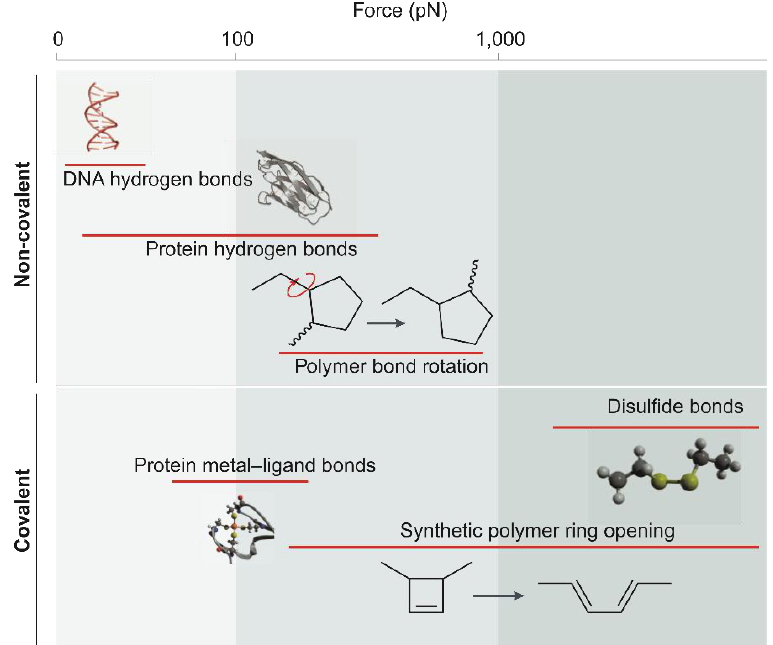
Figure 2. ( Top ) Orders of magnitude of the mechanical forces (spanning up to hundreds of pN) required to disrupt non-covalent interactions such as hydrogen bonds in biomolecules, or to induce molecular fragment rotations of defined groups of bonds. ( Bottom ) The ranges of the mechanical forces required to break covalent bonds, such as metal-organic bonds in proteins, disulfide bonds, and the ring opening of mechanophores in polymers. Note that the forces to break covalent bonds can be higher, in the nN order of magnitude. Figure reprinted by permission from Springer Nature, in Nature Reviews Chemistry , “ Steering Chemical Reactions with Force, ” by S. Garcia-Manyes and A. E. M. Beedle, 2017.